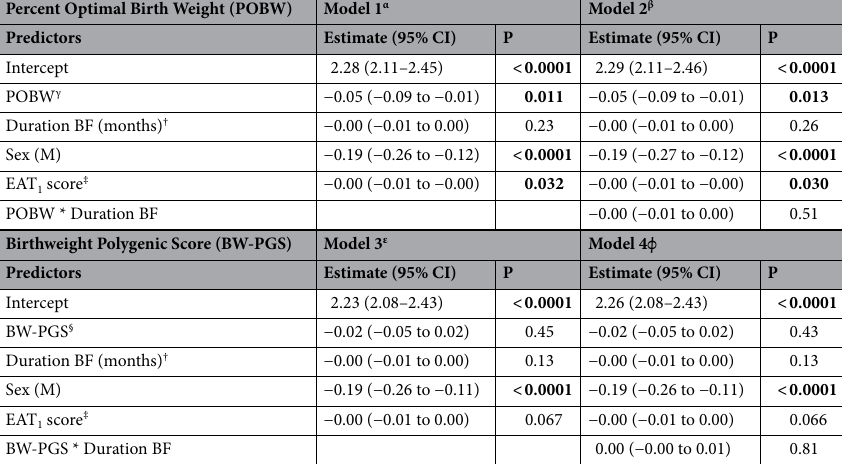
Table 4. Association analyses for Fasting Serum Insulin (Natural Log Transformed). γ POBW = Percent Optimal Birth Weight (standardised); † Duration of BF = Duration of any breastfeeding (mean-centred); ‡ EAT 1 score = quality of early life nutrition in first year of life; § BW-PGS = birth weight polygenic score (standardised); δ adjustment for population stratification; α Model 1 examines the effect of duration of breastfeeding adjusting for POBW, sex and EAT 1 score; β Model 2 examines the effect modification of duration of breastfeeding by POBW adjusting for sex and EAT 1 score; ε Model 3 examines the effect of duration of breastfeeding adjusting for BW-PGS, sex, EAT 1 score and the first two principal components [PCs] (estimates not presented); 4 examines the effect modification of duration of breastfeeding by BW-PGS adjusting for sex, EAT 1 score and the first two principal components [PCs] (estimates not The polygenic score, developed from a set of variants, mimics fine-mapping by capturing variants which could explain precise genetic and biological mechanisms underlying the phenotype of interest 22 ; this provides more power with less bias than single SNP approaches.